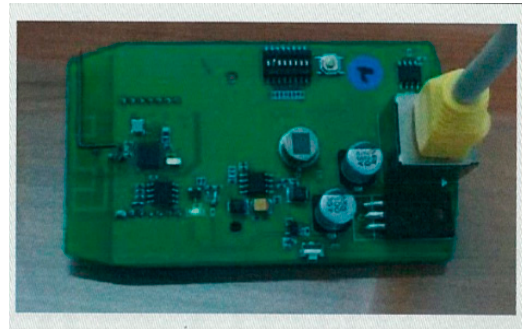
Figure 15. Hardware of BLE receiver, and beacon gateway.